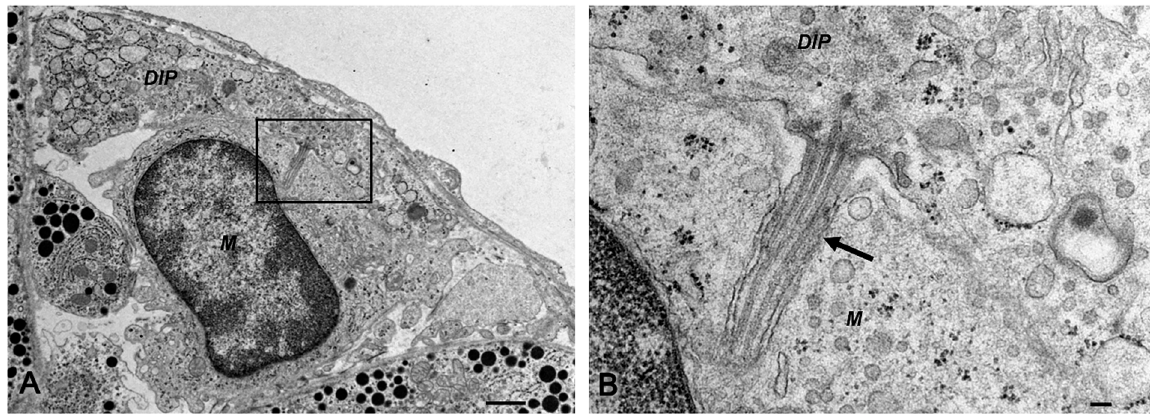
Figure 4. Conventional transmission electron microscopy of novel desmin-immunopositive perivascular cells, DIP and macrophages, M ( A , B : higher magnification of squared area in A ). A single cilium (arrow) extends from the novel desmin- immunopositive perivascular cell type. Bars 1 µm ( A ), 0.1 µm ( B ).